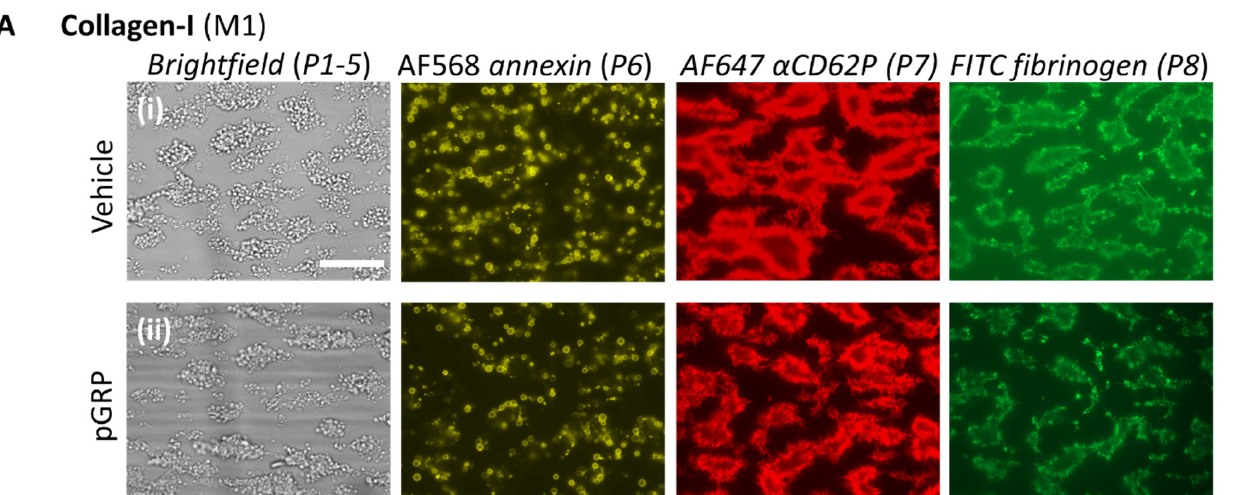
Figure 1. Effect of GPR56 interference on collagen-induced thrombus formation at a high shear rate. Whole blood (700 μ L) was pre-incubated with vehicle medium or pGRP peptide (50 μ g/mL) for 10 min. After recalcification, blood samples were perfused over microspots of collagen I, III, and IV for 3.5 min at wall-shear rate of 1600 s − 1 . Brightfield and fluorescence images were taken per microspot at end stage. ( A ) Shown are representative microscopic images for collagen I of ( i ) vehicle control runs or ( ii ) pGRP runs. Scale bar = 10 μ m. Complementary images for thrombi on collagen III and collagen IV are shown in Figure S1. ( B ) Cumulative plots per condition of scaled (0–10) image pa- rameters: P1, platelet adhesion; P2, platelet aggregate coverage; P3–5, thrombus morphology, mul- tilayer and contraction scores; platelet activation markers: P6, PS exposure; P7, P-selectin expression; P8, fibrinogen binding (see Table 1). Shown are means of duplicate runs for three donors. Mean values ± SD (n = 3); n.s., not significant, ** p < 0.005, *** p < 0.001 vs. vehicle (paired Student’s t -test). 2.2. Effects of the GPR56 Peptide Combined with PTK2 Inhibition on Thrombus Formation under Shear Given the proposed mechanism of GPR56 in shear- and G13 α -dependent platelet ac- tivation [32], we hypothesized that its role could be masked by integrin α IIb β 3 outside-in signaling, in which the focal adhesion kinase PTK2 plays a central role [17,36,37]. To in- vestigate this, we used two structurally different PTK2 inhibitors, PF573228 and FAK- IN14, of which the former was tested before on human platelets [38,39]. Initial dose-re- sponse experiments (2.5–10 μΜ) indicated a more potent effect of PF573228 than of FAK- IN14 on collagen-induced platelet aggregation (Figure 2A,B), which agrees with earlier published IC 50 values [38,40]. As expected, under the slowly stirred conditions (1200 rpm providing a low shear rate) in light transmission aggregometry, the addition of pGRP did